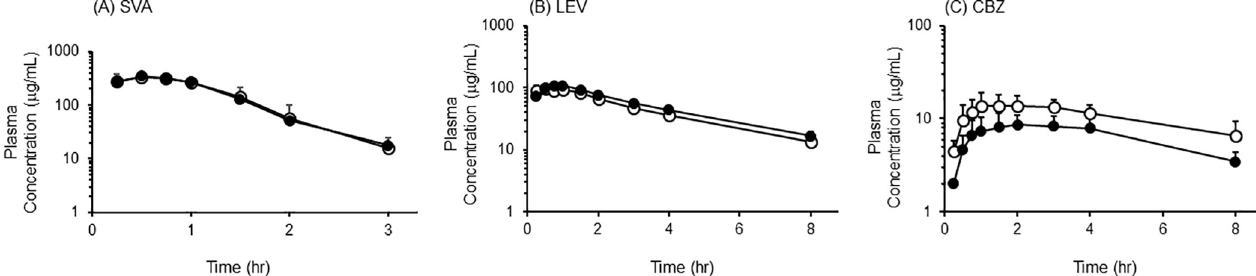
Fig 1. Serum concentration-time courses of SVA, LEV, and CBZ after concurrent oral administration with RASS. Serum concentrations of SVA (A), LEV (B), and CBZ (C) were measured after oral administration. Results are shown as the means ± SD of five rats per group. Open circles: short-term group; Closed circles: long-term